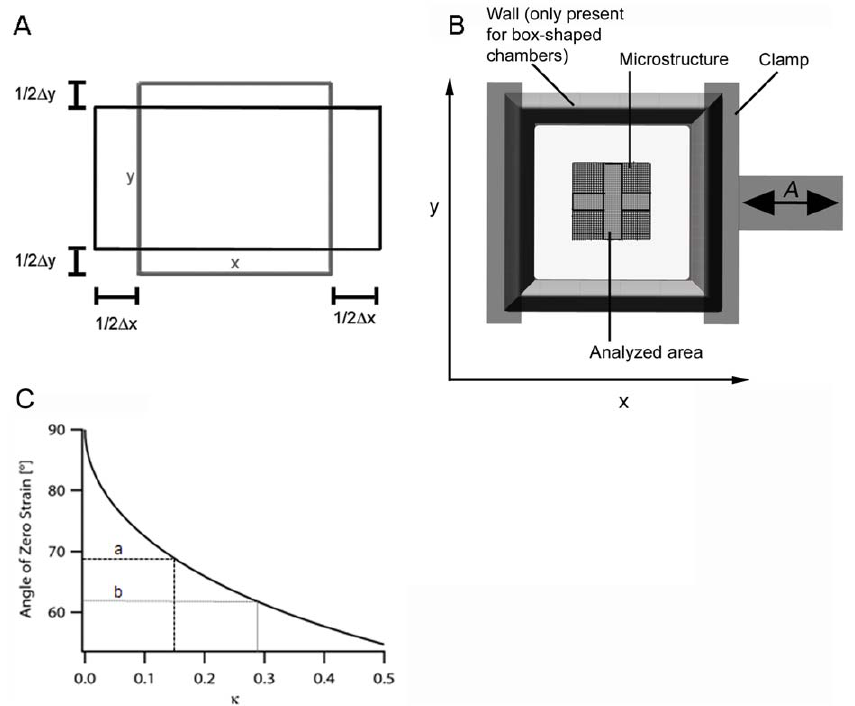
Figure 1. Interplay of elongation and contraction in stretching chambers. (A) An incompressible elastic material in uniaxial stress (i.e. forces act exclusively along one direction) exhibits a transversal shrinkage of exactly half the elongation along the direction of force. That is, upon elongation of an elastomeric film in x-direction, a film characterized by a Poisson’s ratio of 0.5 is shortened in y-direction with D y= K D x. For adhered cells this results in tensile strain in x- and contractile strain in y-direction. (B) Scheme of the stretching design. An elastomeric chamber was formed of silicone rubber exhibiting a bulky 5 mm thick wall all around an approximately 400 m m thin film (Young’s modulus 50 kPa, Poisson’s ratio=0.5). The chamber (length 20 mm, width 20 mm) was clamped on two opposite sides and stretched with controlled amplitudes A in x-direction. Exact substrate deformations applied to the cells were quantified by mapping a regular micro-pattern embedded in the silicone rubber film. All cells adhered in the indicated cross were analyzed. Ribbon-like chambers display an identical design except that bulky walls in x-direction (direction of stretch) are missing. (C) Dependence of zero strain direction on the measured transversal shrinkage factor k ( k = 2 D y/ D x). In theory k can assume values from 0 (fully blocked perpendicular shrinkage upon film elongation) to 0.5 (free shrinkage upon